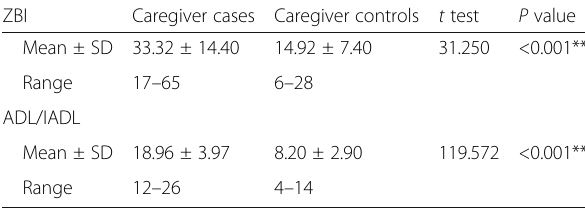
Table 2 Assessment of caregiver ’ s burden